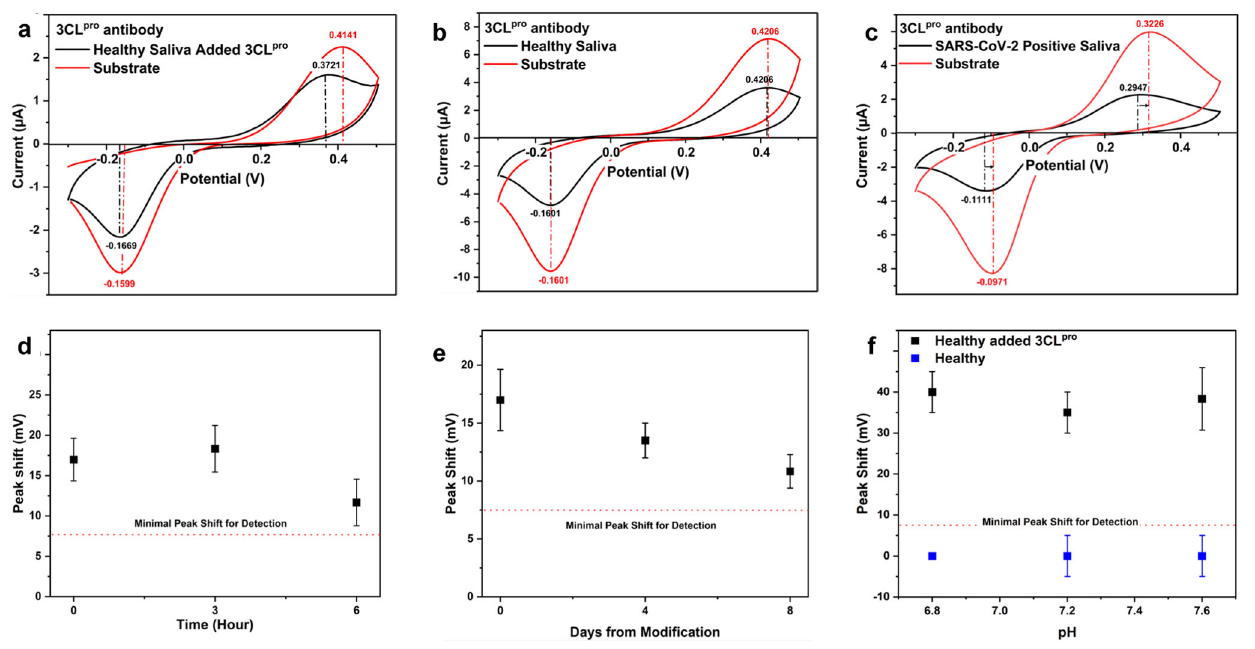
Fig. 4 | CV performance of CPE for SARS-CoV-2 detection. a CV curves of CPE treated with 3CL pro antibody and exposed to SARS-CoV-2 negative saliva spiked with 0.2pmol 3CL pro before (black) and after (red) exposure to 3CL pro substrate. b CV curves of CPE treated with 3CL pro antibody and exposed to SARS-CoV-2 negative saliva before (black) and after (red) exposure to 3CL pro substrate. c CV curves of CPE treated with 3CL pro antibody and exposed to PCR SARS-CoV-2 posi- tive saliva, before (black) and after (red) exposure to 3CL pro substrate. d pBQ oxi- dation peak shifts of healthy saliva spiked with SARS-CoV-2 3CL pro 50 µ gml − 1 measured at different times from saliva spiking. After spiking, the spiked saliva